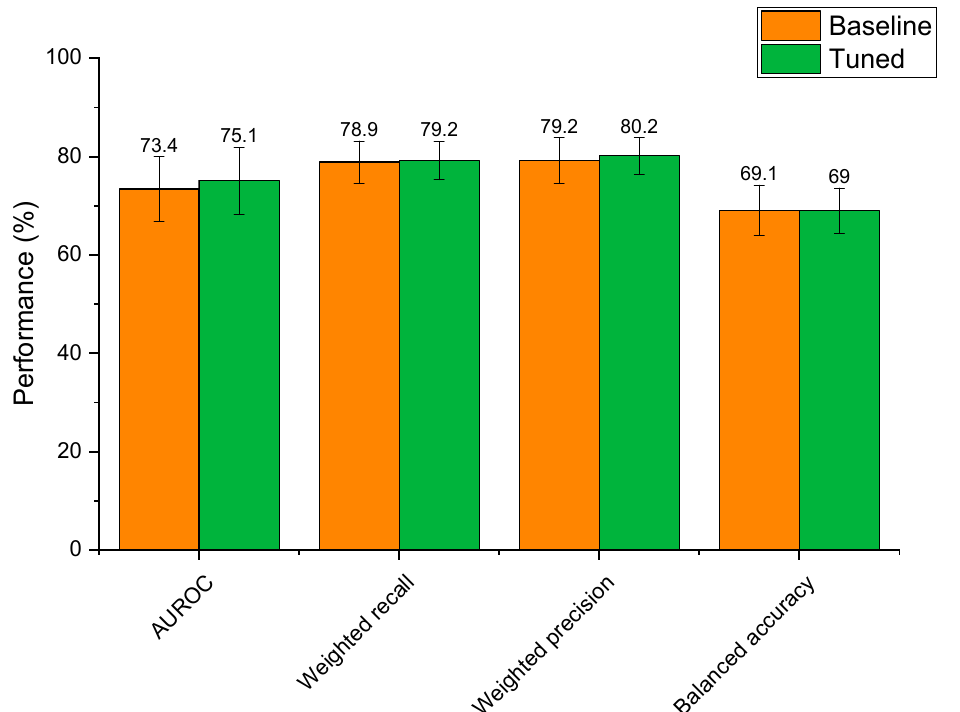
Figure 6. Performance of the baseline extra trees model compared to the extra trees model with hyperparameter tuning.